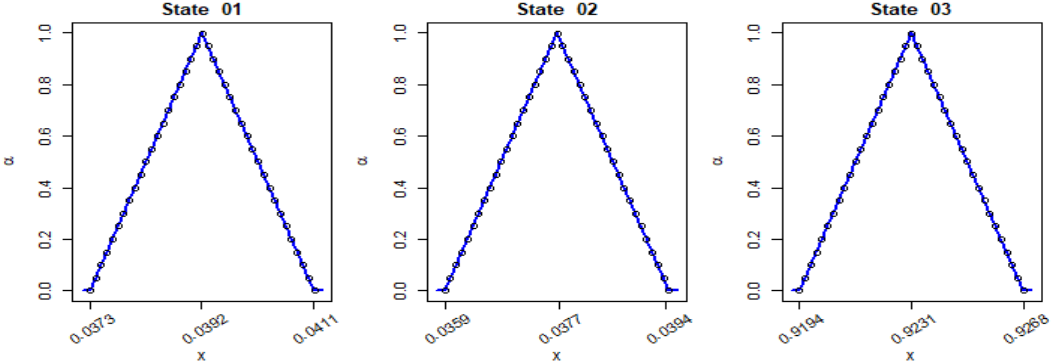
Figure 2. Results of Numerical Application 2. Source: Own elaboration.